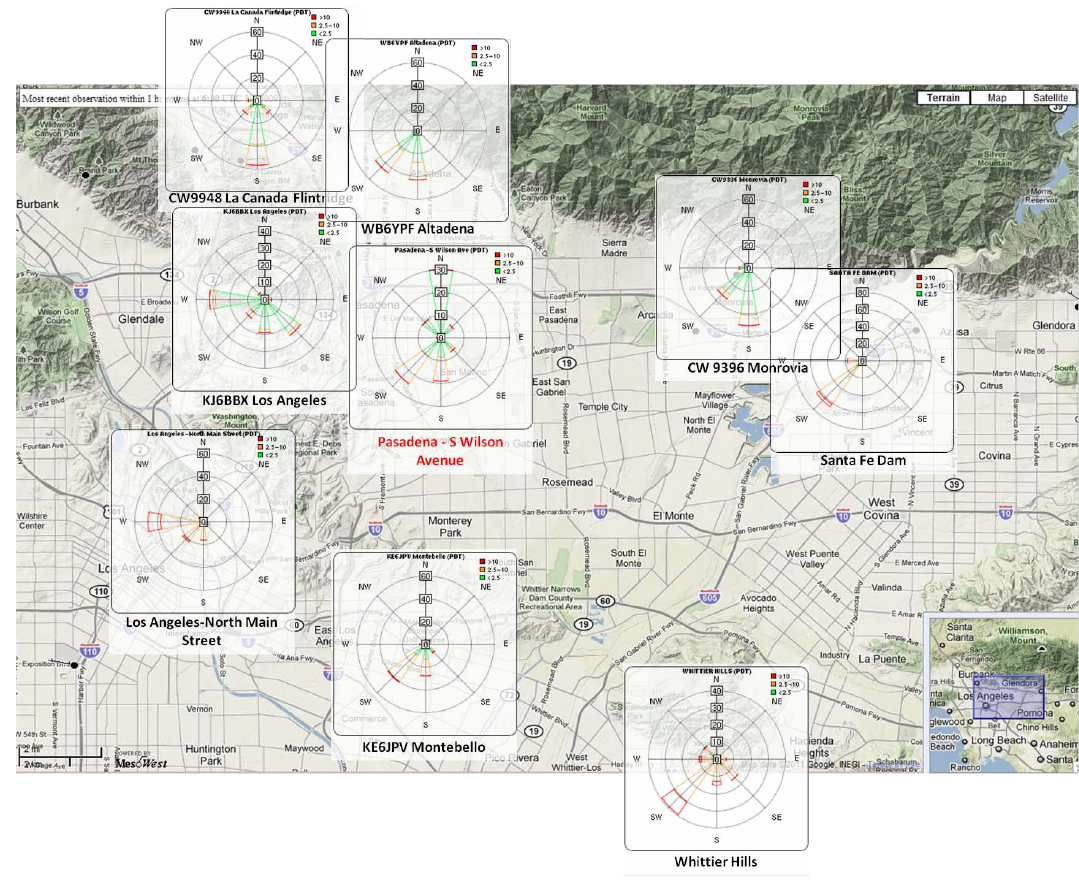
Fig. 3. Wind roses for the month of July for South Wilson Avenue and surrounding stations (data from Mesowest, http://mesowest.utah.edu/